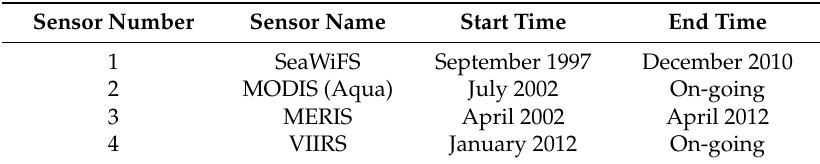
Table 1. Information of the Sensors Used in the OC-CCI